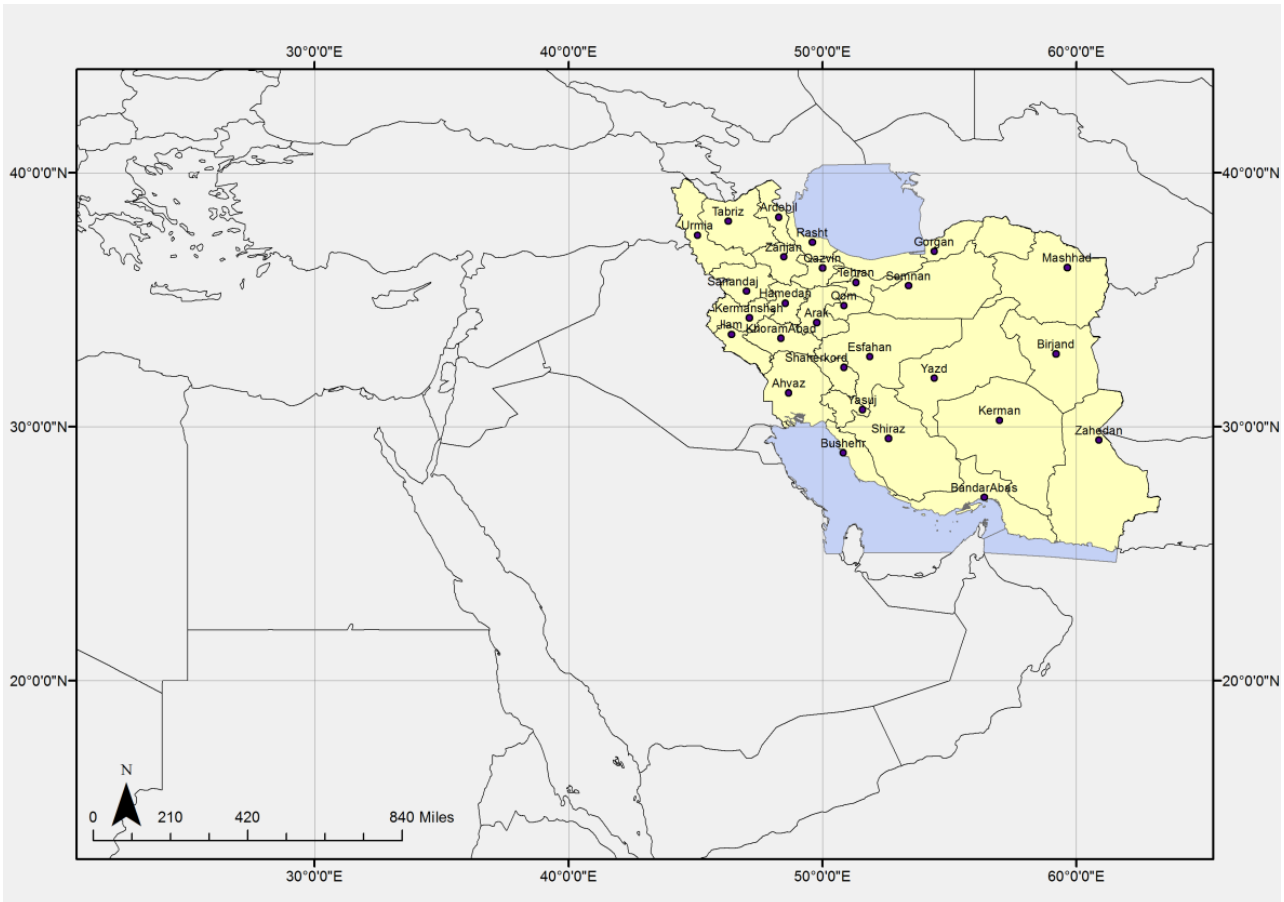
Figure 1. Study area.